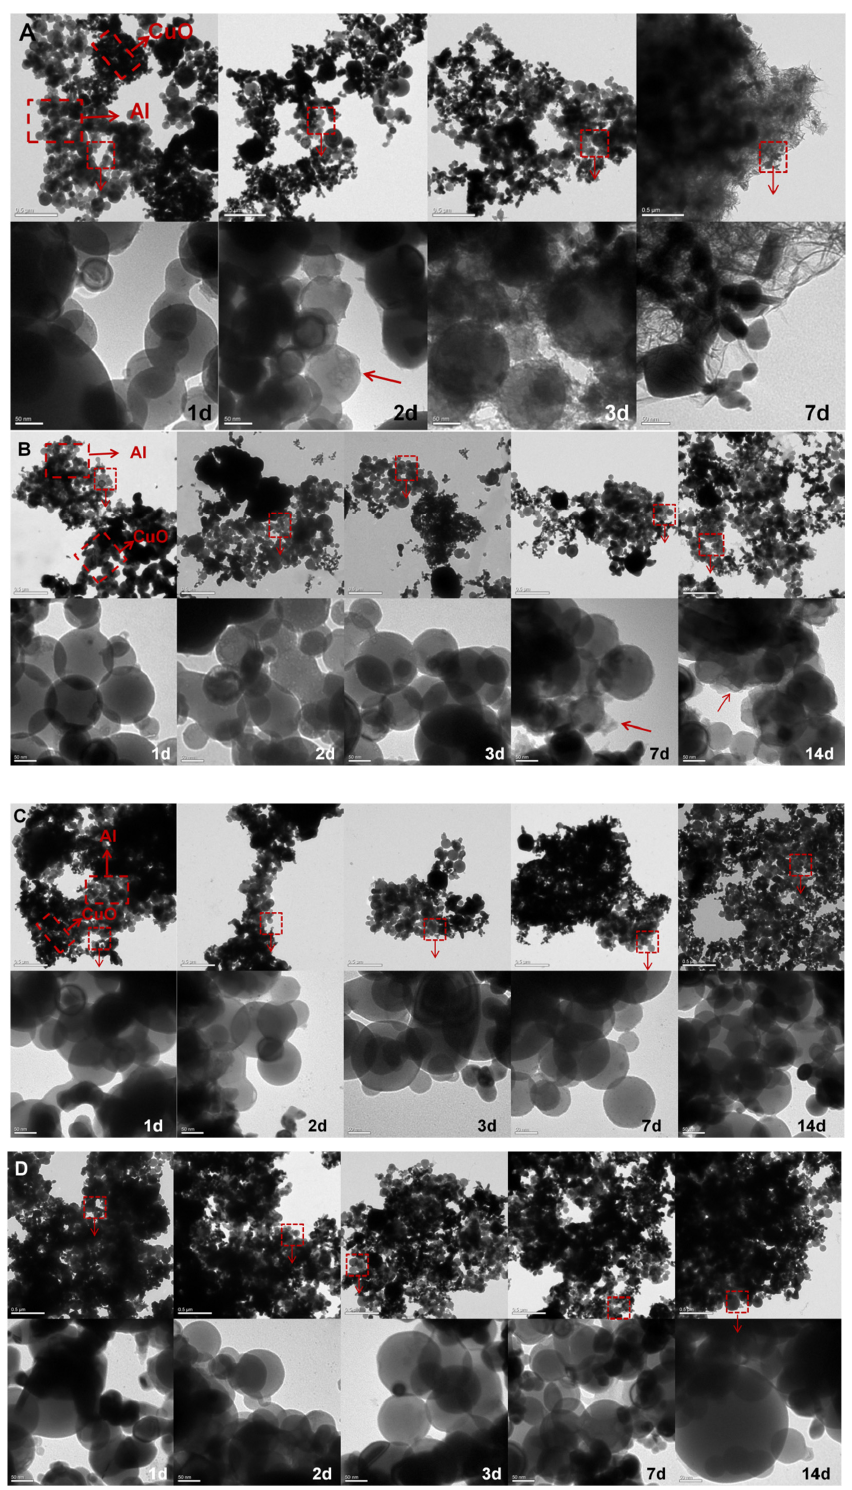
Figure 3. Room-temperature oxidation study of Al and CuO dispersed in an aqueous solution. ( A ) TEM micrographs of H 2 O/Al/CuO comixture at regular intervals during H 2 O exposure. ( B ) TEM micrographs of H 2 O/SH-25/Al/CuO at regular intervals during H 2 O with the peptide SH-25 exposure. ( C ) TEM micrographs of PBS/Al/CuO comixture at regular intervals during PBS exposure. ( D ) TEM micrographs of PBS/SH-25/Al/CuO at regular intervals during PBS with the peptide SH-25 exposure. To further study the protective interactions between them, the pH of these systems was tested during the time of this study (Figure 4). A variation of pH was observed for the aqueous solution in the H 2 O/SH-25/Al/CuO and H 2 O/Al/CuO comixture system due to the slow oxidation of Al NPs. The pH increased from 5.1 to 7.0 within 7 days when the solution was in H 2 O. In the H 2 O/SH-25/Al/CuO system, the pH increased from the original 5.0 to 5.7. A higher pH change was observed in the H 2 O/Al/CuO system, indicating that the oxidization of Al NPs took place at a faster rate, which coincides with the results ob- tained from TEM. Figure 4. Investigation of the pH solution at room temperature. DLS and zeta-potential measurements were used to track the features of CuO and Al NPs as they were assembled [21,31].